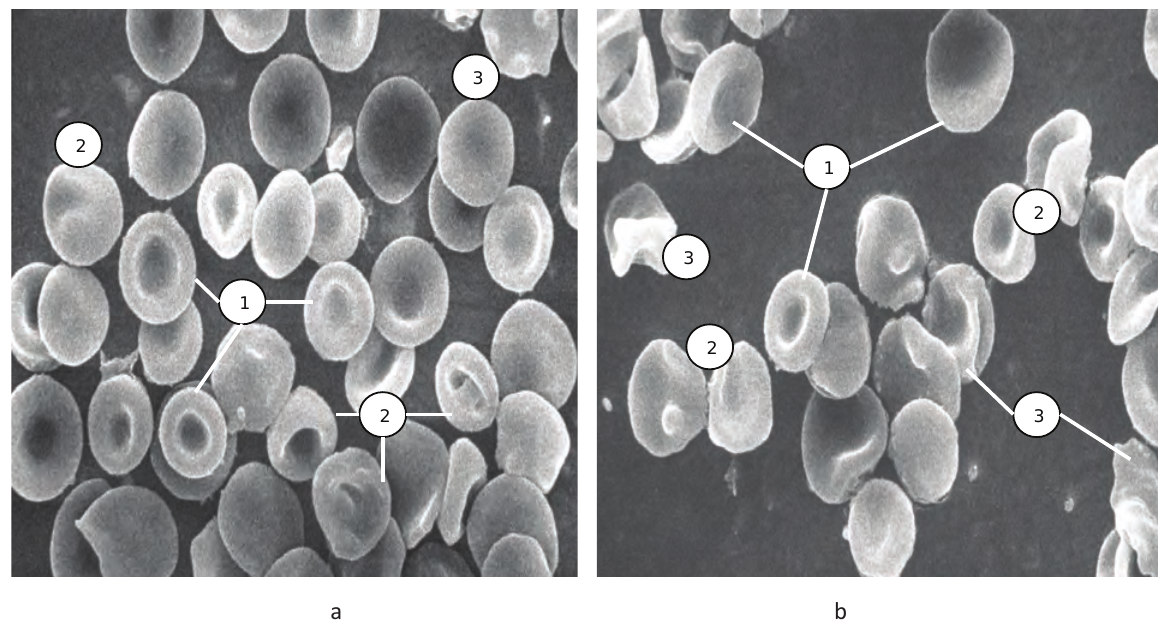
Fig.1 Structural reconstruction of periphery blood erythrocytes in 1st (a) and 2 (b) groups’ volleyball players with hypo-kinetic hemo-dynamic type after single maximal physical load. Legend: 1 – normal forms of erythrocytes; 2 - reversibly changed forms of erythrocytes; 3 – irreversibly changed forms of erythrocytes. The method is – scanning electronic microscopy, scale: 1500:1.